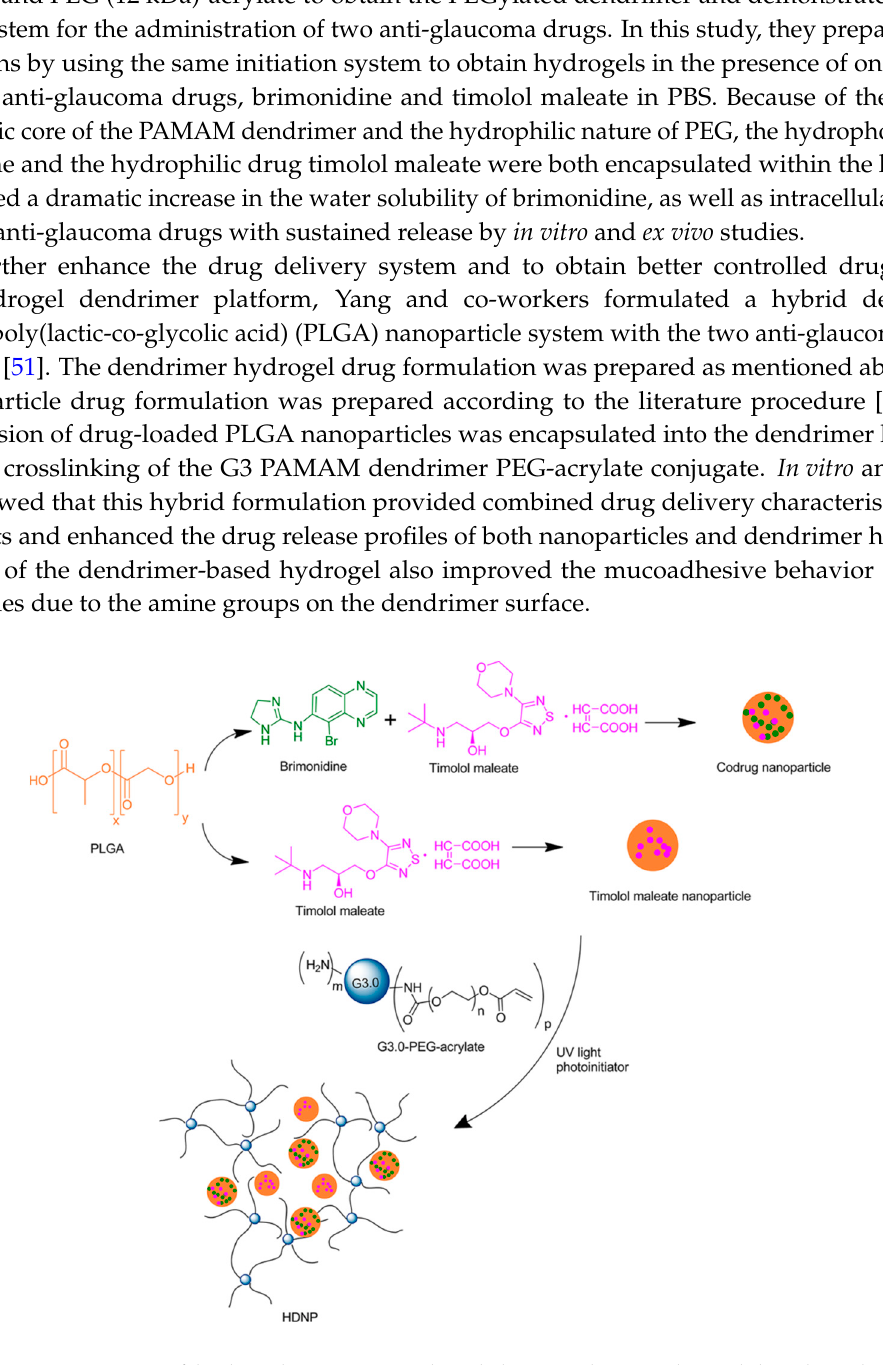
Figure 21. Synthesis of the photoreactive poly(amido amine) (PAMAM) dendron PEG conjugate and photoinitiated crosslinking for hydrogel formation. Reprinted with permission from [49], Copyright © 2010 American Chemical Society.